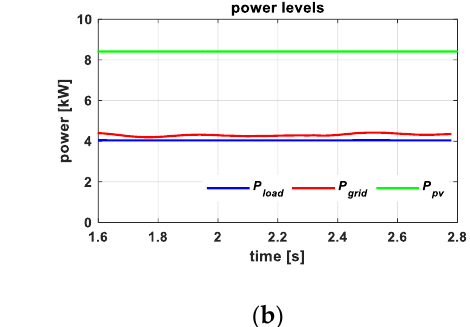
Figure 10. Point of common coupling (PCC) voltage envelope middle values (circles).